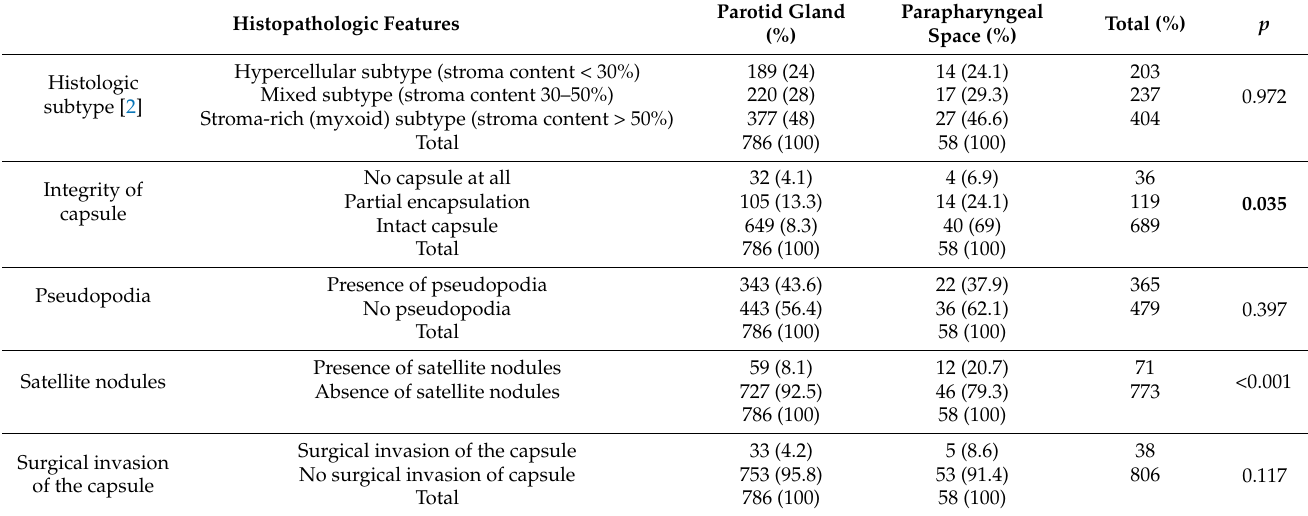
Figure 1. Pleomorphic adenoma of the parapharyngeal space with focal absence of the fibrous capsule, presence of satellite nodules, and a close surgical margin with sparse or no presence of fatty tissue. Table 2. Comparative analysis of the histopathologic parameters in pleomorphic adenomas of the parotid gland and parapharyngeal space in our study ( p values in bold: statistically significant).